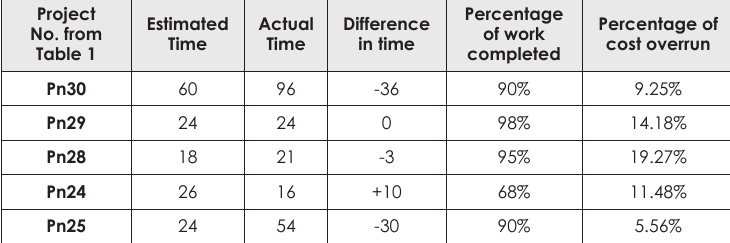
Projects that have ‘high percentage of work completed’ and ‘low cost